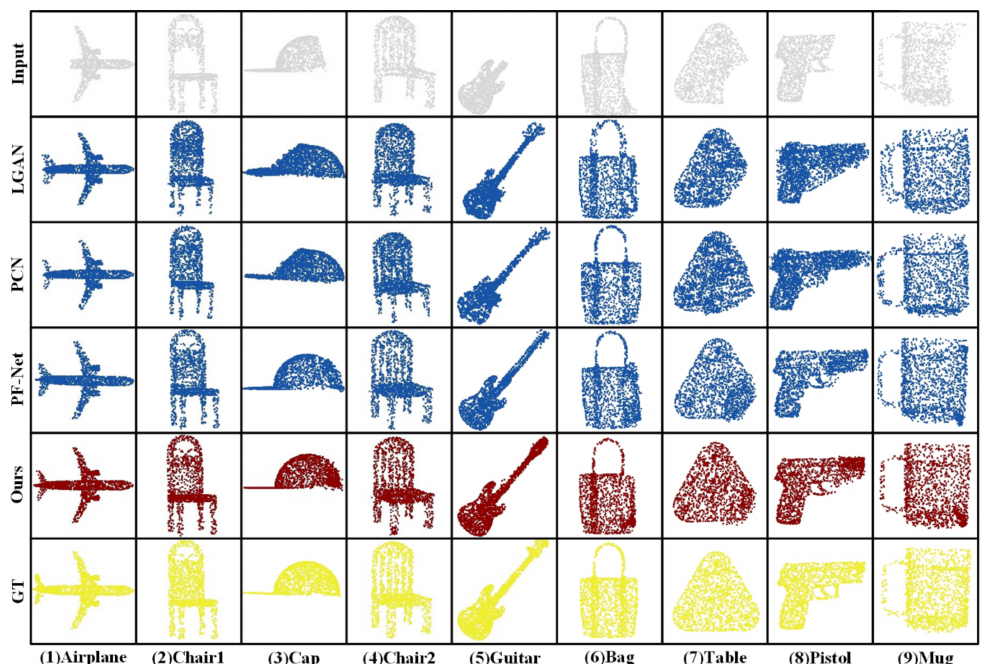
Figure 9. Comparison of point cloud completion results of other methods and those of the proposed